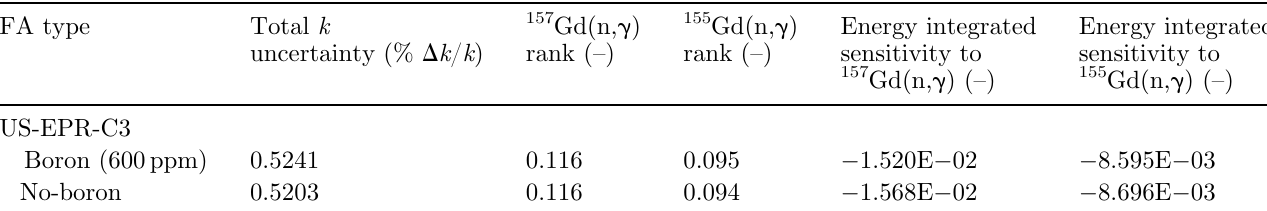
Table 6. Effect of boron concentration on sensitivity and uncertainty data.